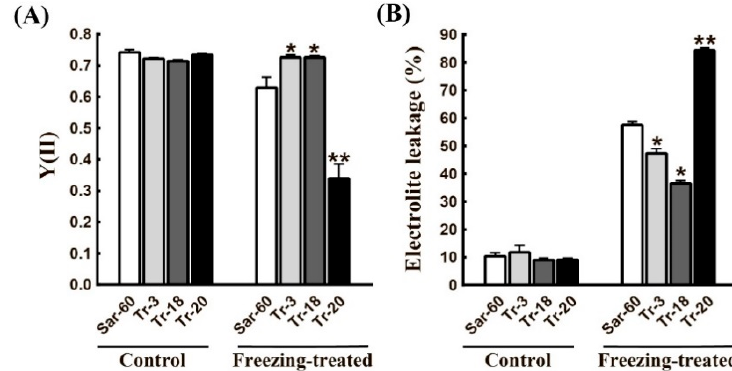
Figure 6. Freezing tolerance test of transgenic wheat plants overexpressing AtOPR3 . Freezing treatments were performed on homozygous T2 plants, as described in the Materials and Methods section, and